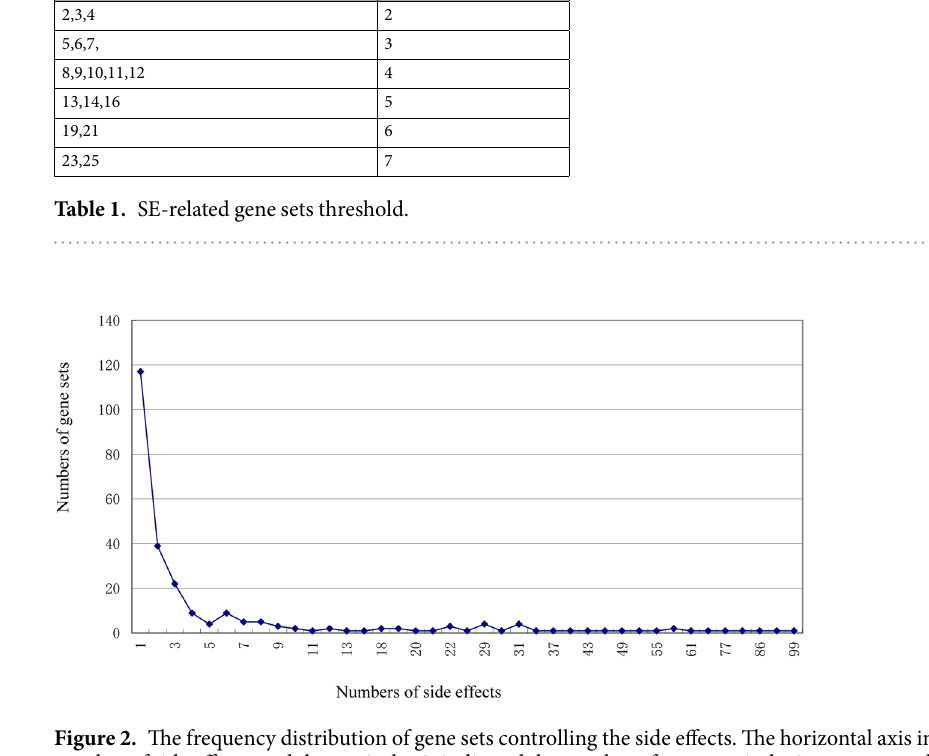
Figure 2. The frequency distribution of gene sets controlling the side effects. The horizontal axis indicated the number of side effects, and the vertical axis indicated the number of gene sets inducing corresponding side effects. The results showed that each gene set regulated 8.06 SEs averagely, and most of gene sets were associated with the minority of side